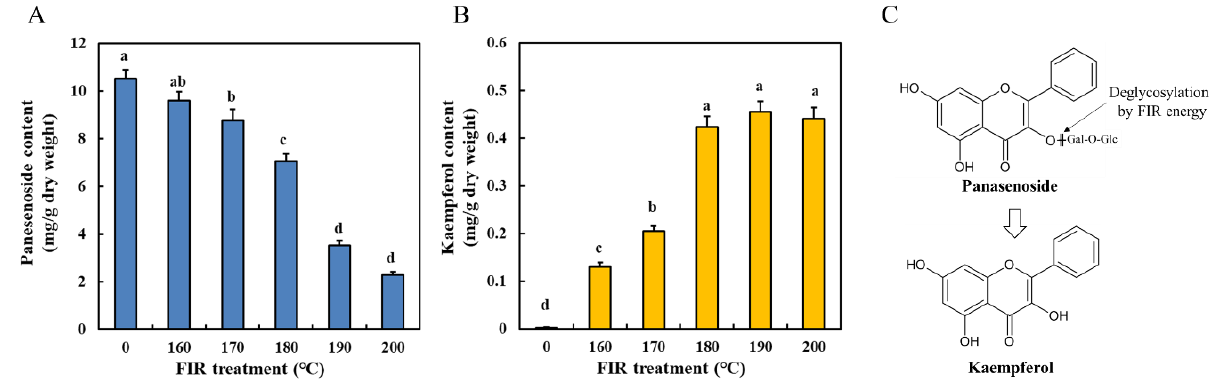
Figure 2. Changes in panasenoside ( A ) and kaempferol ( B ) contents and structural conversion pattern ( C ) from panasenoside to kaempferol in ginseng leaves treated by FIR at different temperatures. The values are expressed as the mean with standard error ( n = 3). Different letters (a–d) above the bar graphs indicate significant differences at p < 0.05 on Tukey’s HSD